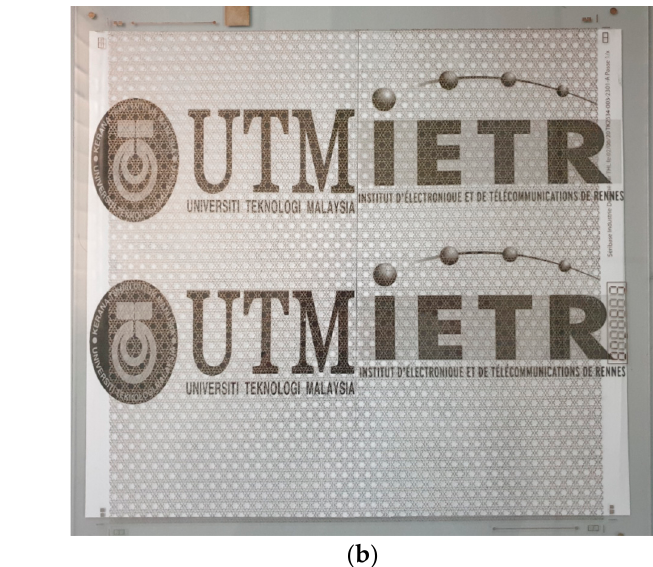
Figure 14. The free space measurement setups for frequency range of ( a ) 2 GHz to 18 GHz, and ( b ) 18 GHz to 40 GHz.